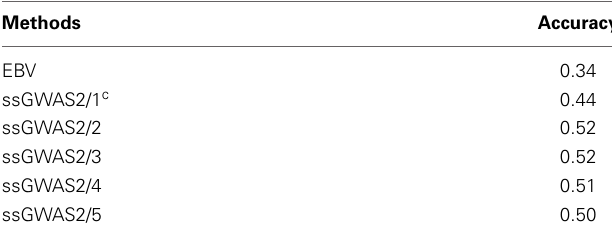
Table 2 | Comparison of accuracies of EBV obtained from regular BLUP and GEBVs a from ssGWAS2 b with up to 5